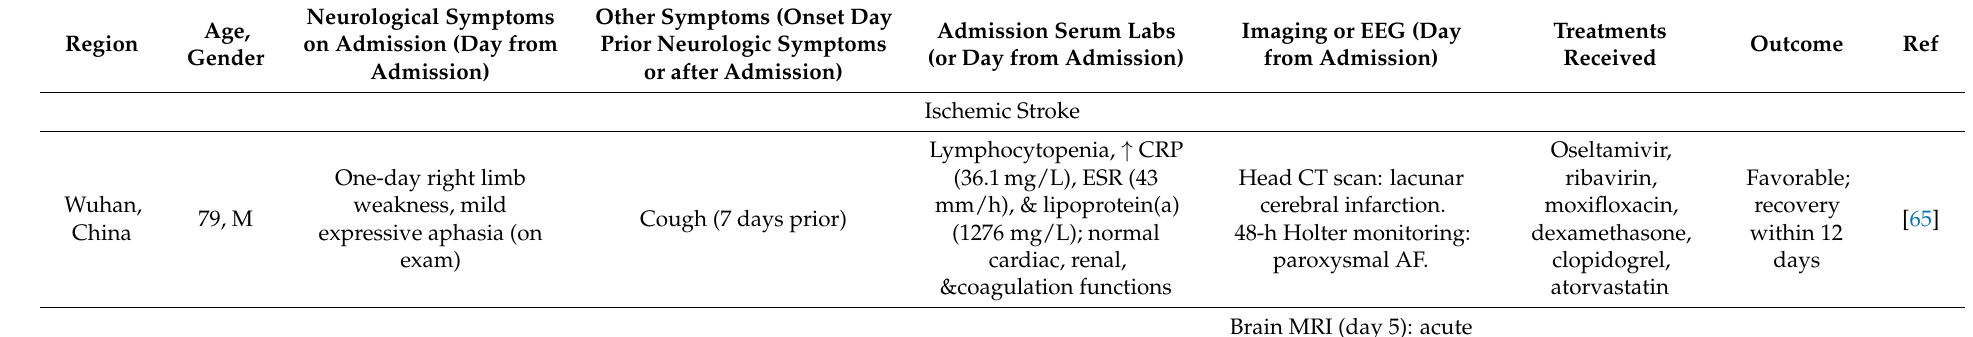
Table 1. Case reports of acute cerebrovascular events related to